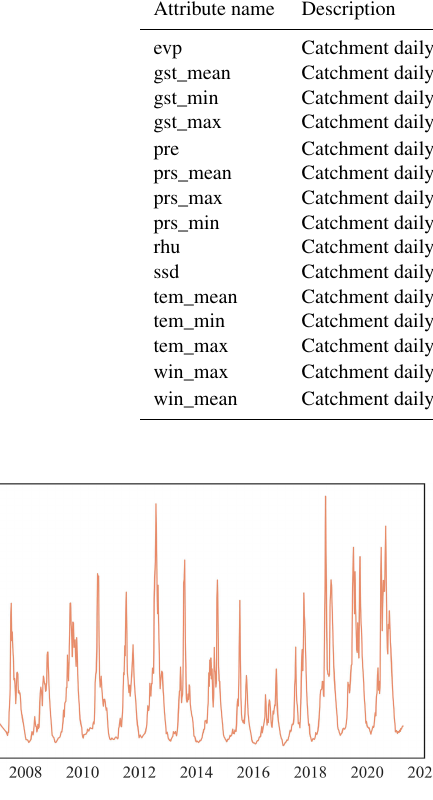
Figure 8. Example of standardized